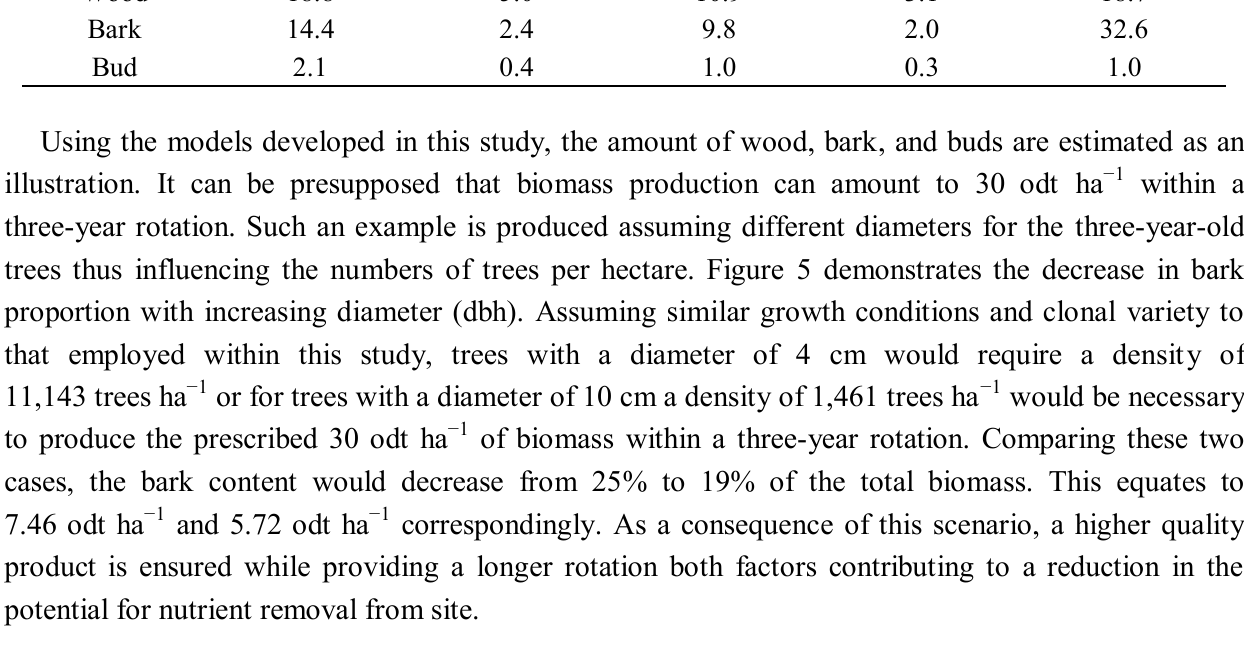
Figure 5. Percentage of biomass compartments assuming a three-year rotation with 30 odt ha −1 of biomass for seven different scenarios with increasing target dbh from 4 to 10